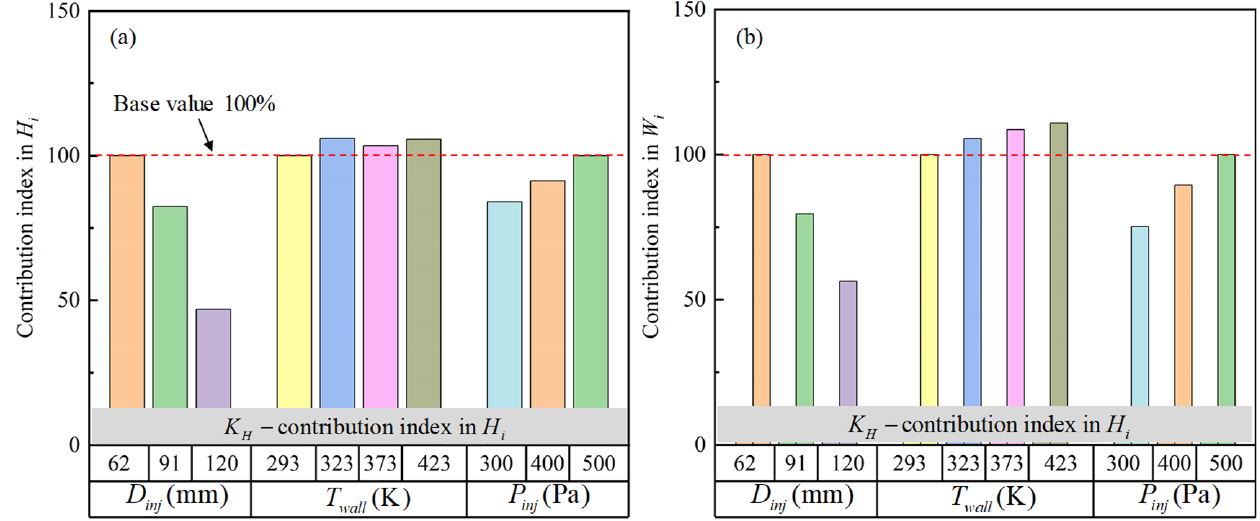
H and ( b ) width W of impinging spray under different i i